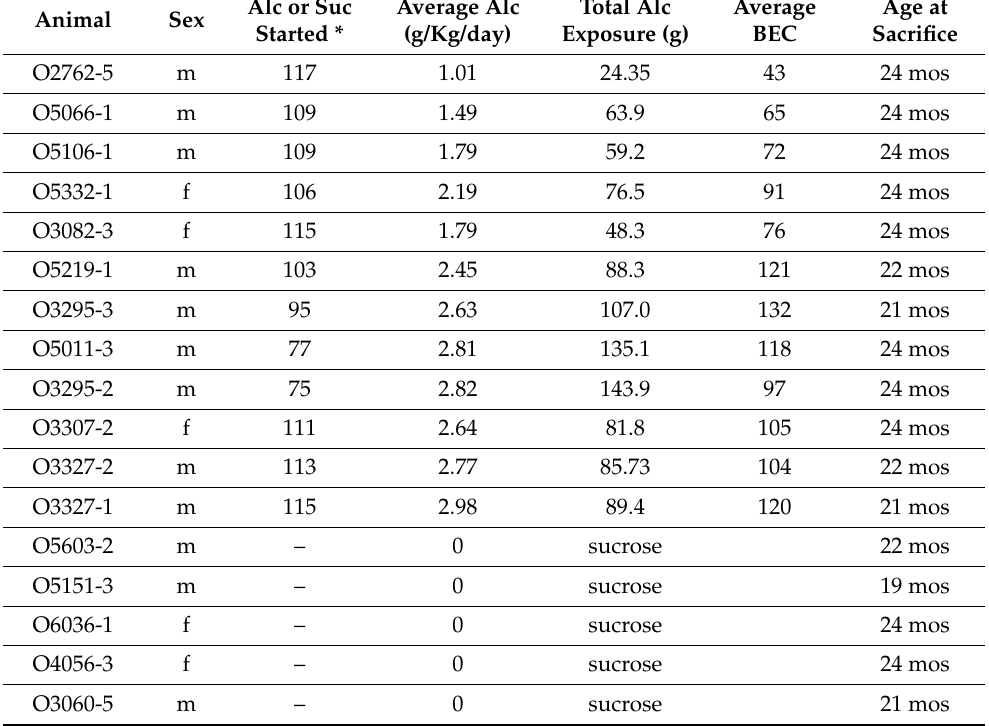
* Day of gestation alcohol or sucrose treatement